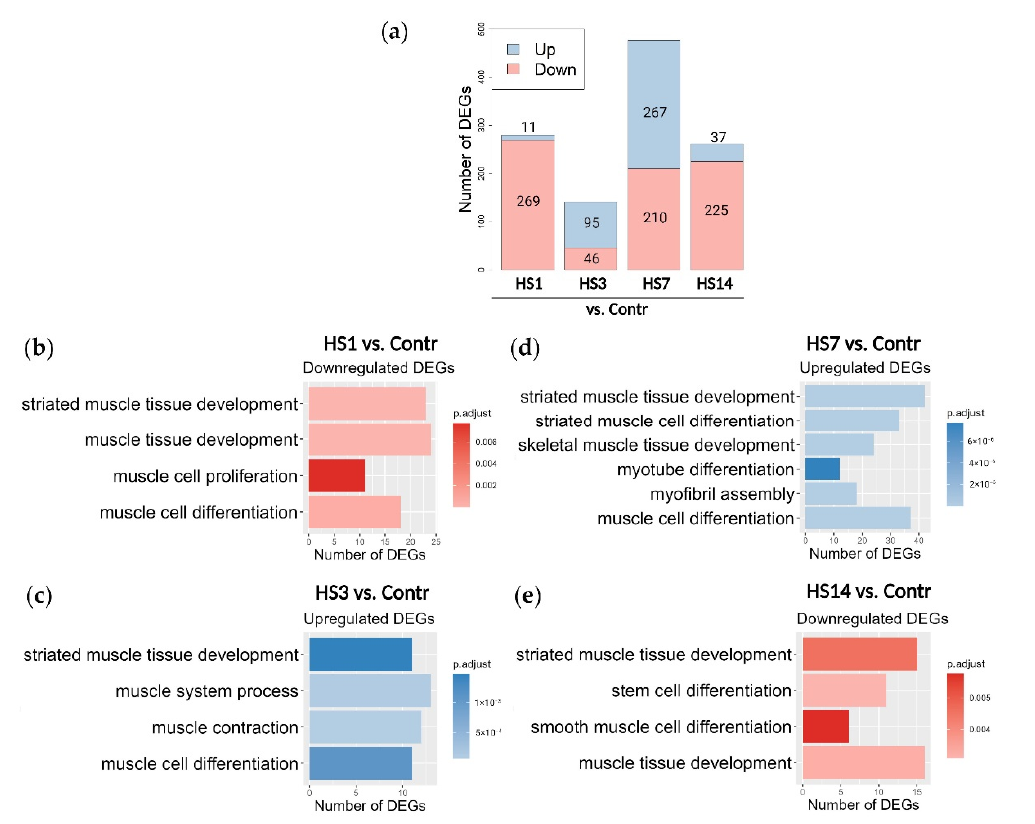
Figure 5. Differentially expressed genes associated with muscle regeneration and differentiation processes: ( a ) Number of up- and downregulated differentially expressed genes (DEGs) found in all four pairs (HS vs. Control); log2 fold change > 1.5, p < 0.01; ( b – e ) GO Enrichment Analysis of upregulated and downregulated DEGs using GO Biological Process database. Table 1. Pathways associated with the DEGs downregulated in HS1 vs. CONTR ( p <